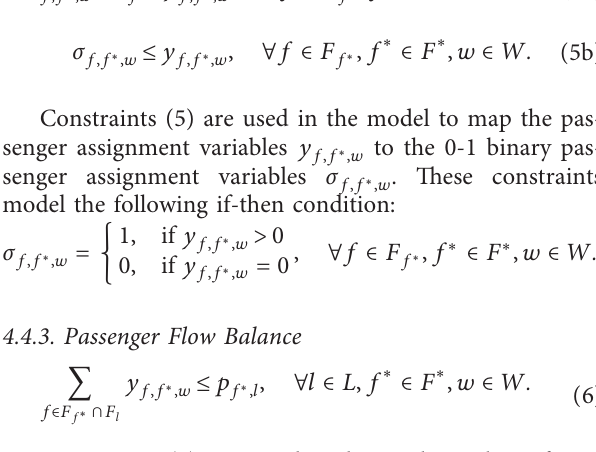
Figure 4: Passenger cost